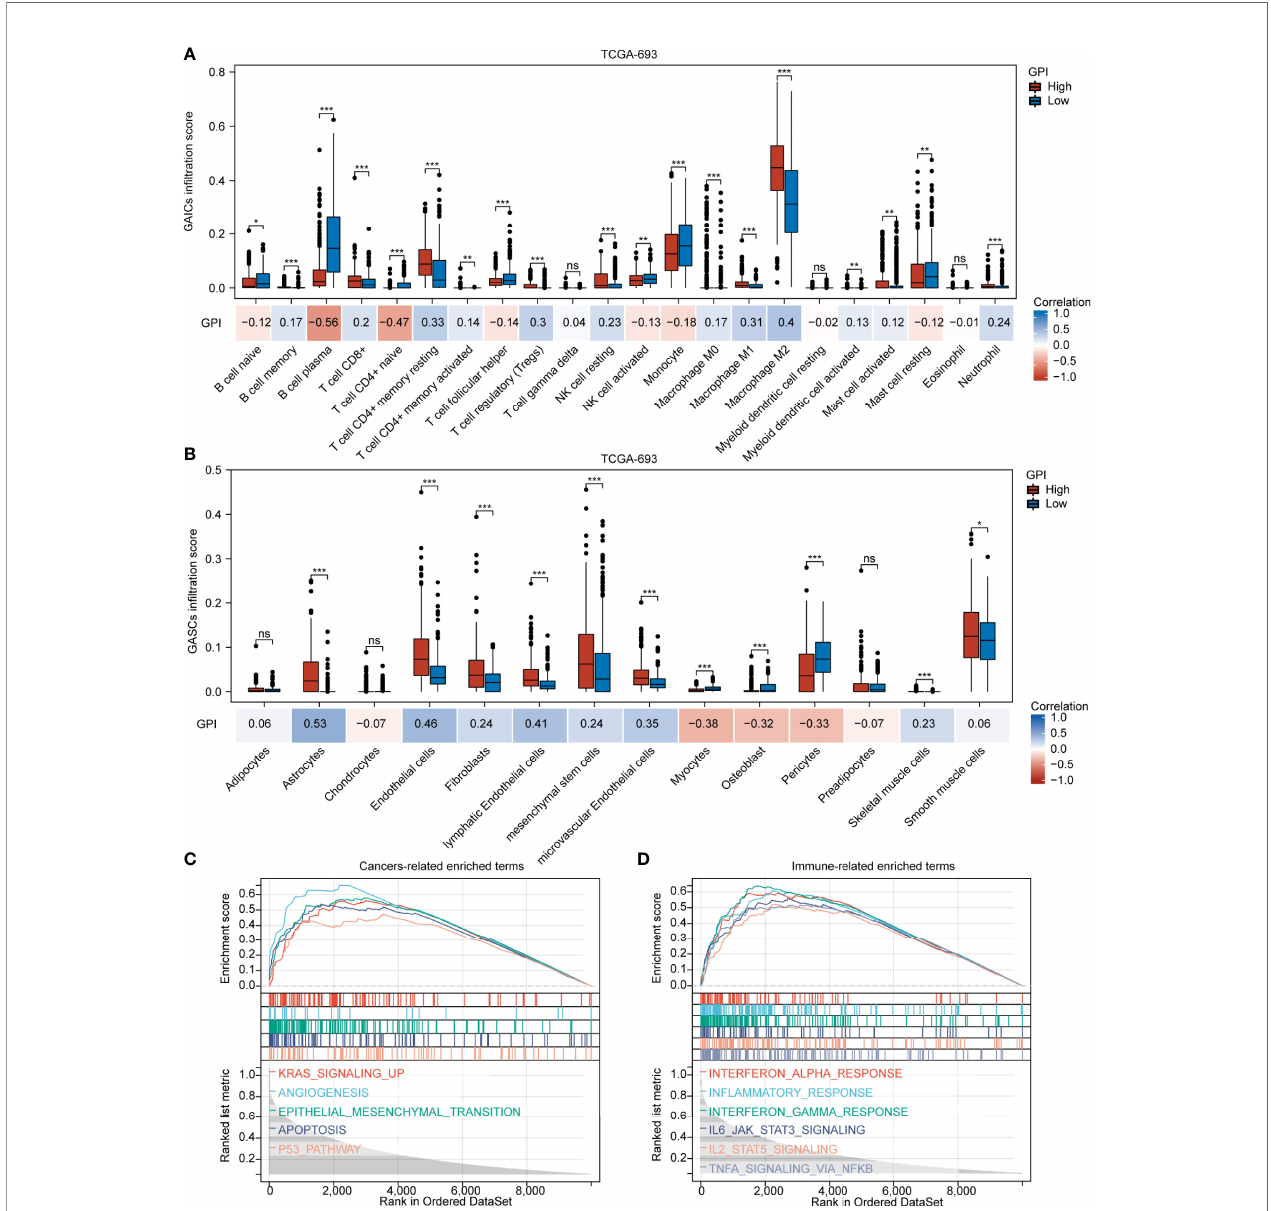
FIGURE 8 | GPI is highly associated with GAIC and GASC in fi ltration. Boxplots showing comparison of the GAIC in fi ltration (A) and GASC in fi ltration (B) between the GPI-high and GPI-low groups. (C, D) Enrichment plots from GSEA. *P<0.05; **P<0.01; ***P<0.001; ns, not signi fi